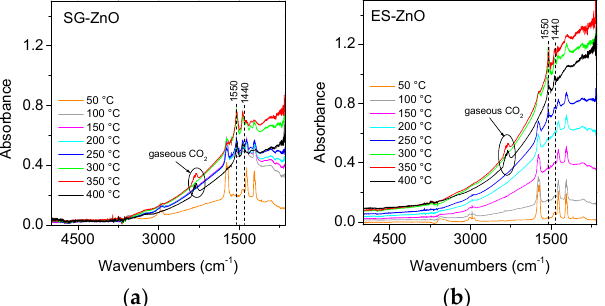
Figure 3. FT-IR spectra of SG-ZnO ( a ) and ES-ZnO ( b ) upon acetone/O 2 interaction at increasing temperature up to 400